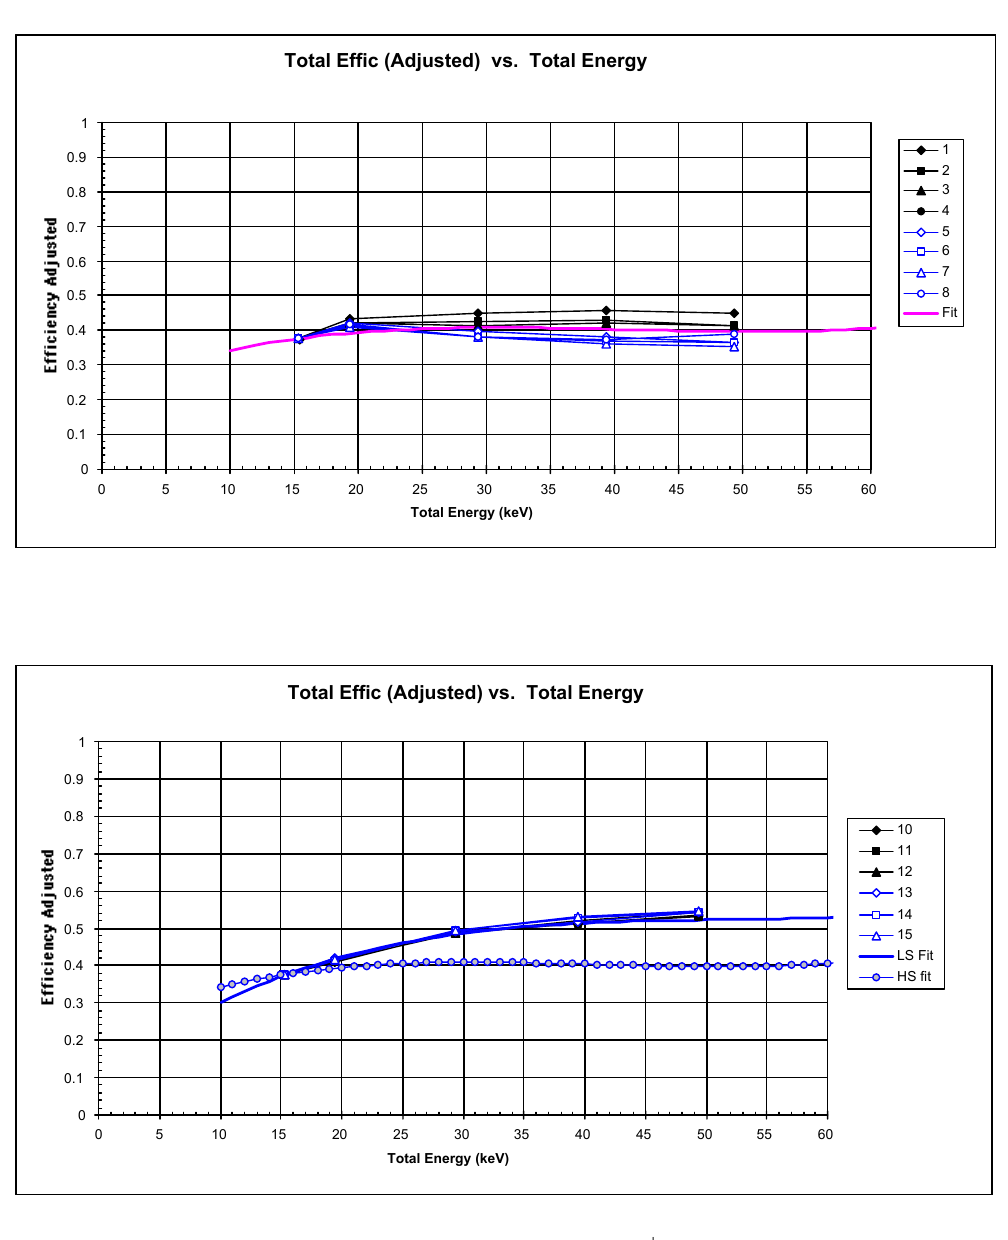
Fig. 14. CODIF FM7 High Side normalised total efficiency verses total energy for He + for the different anodes and with a general fit (upper curve) and CODIF FM7 Low Side normalised total efficiency verses total energy for He + for the different anodes and with a general fit; High Side fit of the upper curve is added (lower